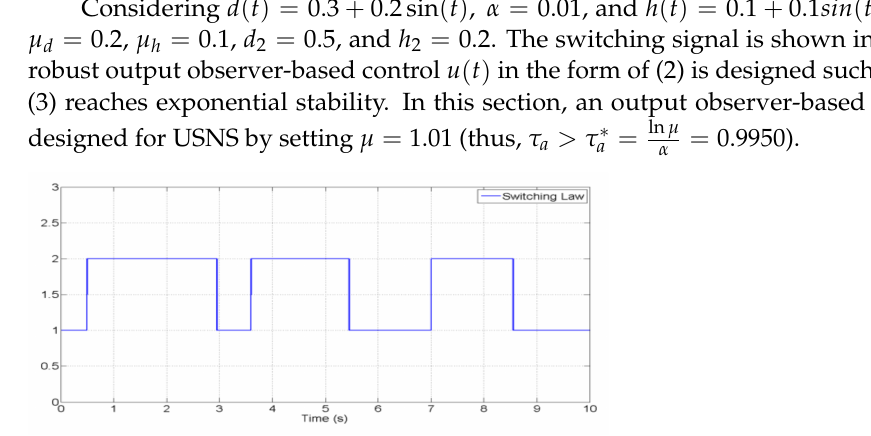
Figure 1. The switching signal where ADT is τ a =